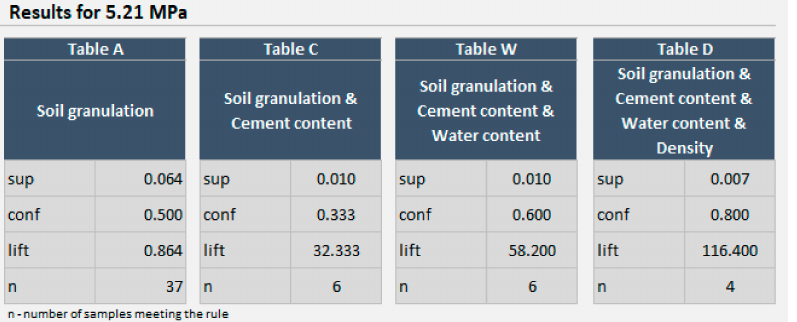
Figure 17. The result from the calculator for 5.21